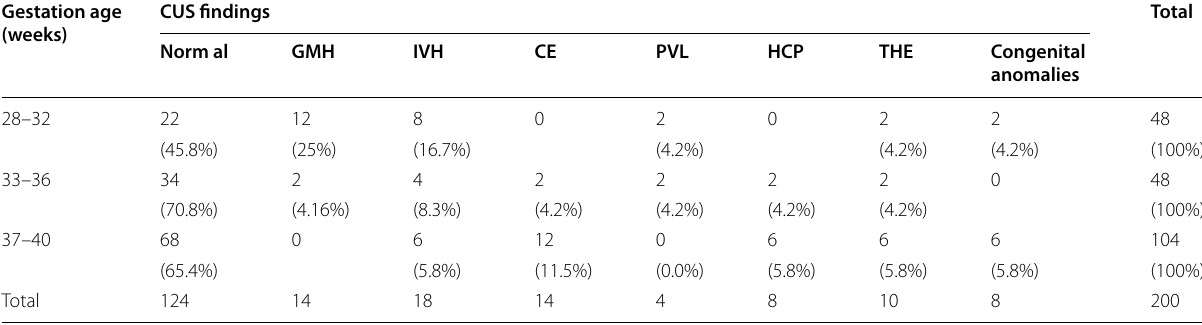
CUS cranial ultrasound, CE cerebral edema, GMH germinal matrix hemorrhage, IVH intra-ventricular hemorrhage, PVL periventricular leukomalacia, HCP hydrocephalus, THE thalamic hyperechogenicity